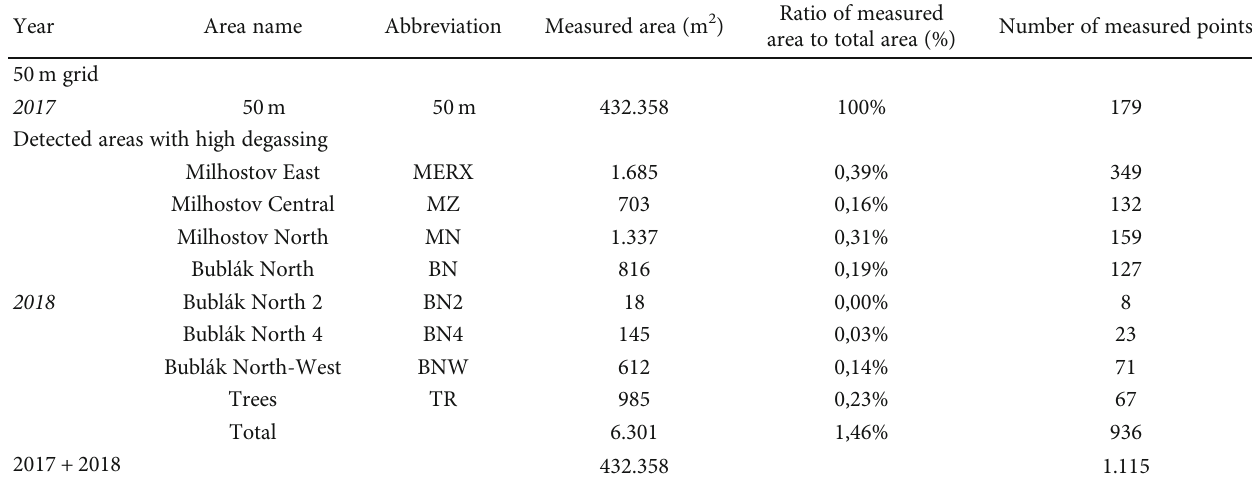
Table 1: Measurement parameters of the areas.